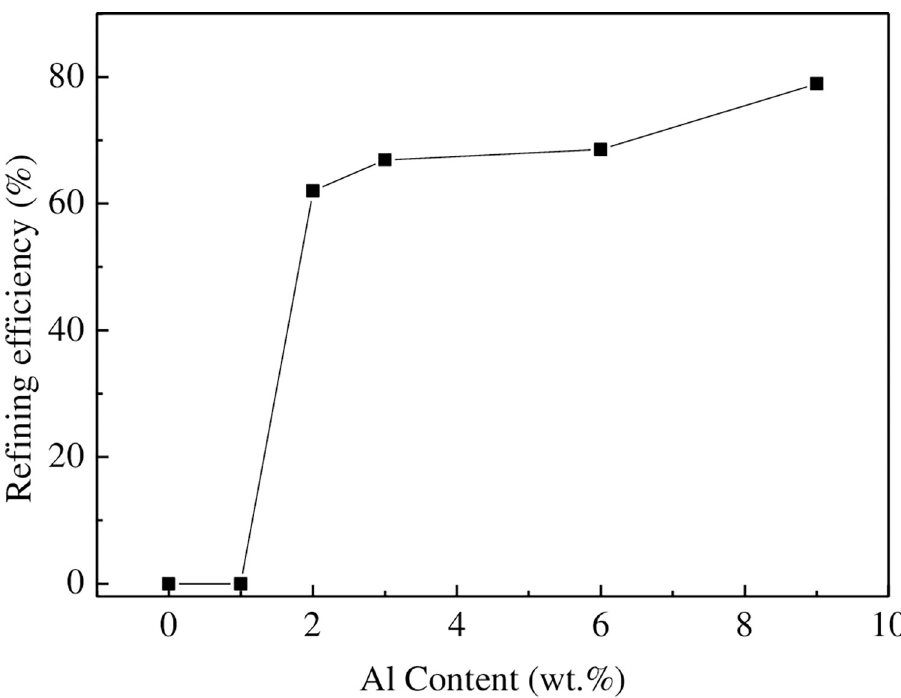
Fig 4. Refinement efficiency of Ar+CO 2 in Mg-Al alloys with different Al